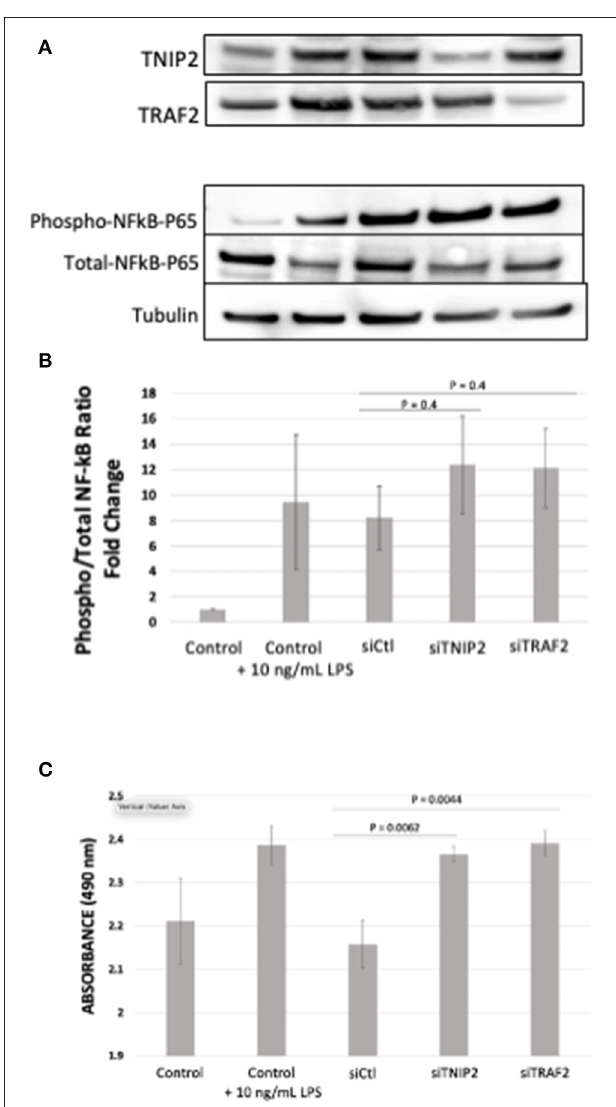
FIGURE 3 | Phospho- to Total-p65-NF- κ B determination and MTS Assay in lung pericytes transfected with siTNIP2 and siTRAF2. (A,B) Representative western immunoblots demonstrating knockdown efficiency of TNIP2 and TRAF2 in healthy lung pericytes transfected with the corresponding siRNA (A) , and the fold change of phosphorylated to total p65-NF- κ B (B) . (C) MTS assay of healthy lung pericytes transfected with siControl (siCtl), siTNIP2, and siTRAF2 under different experimental conditions. The data in the graphs are the average of three independent